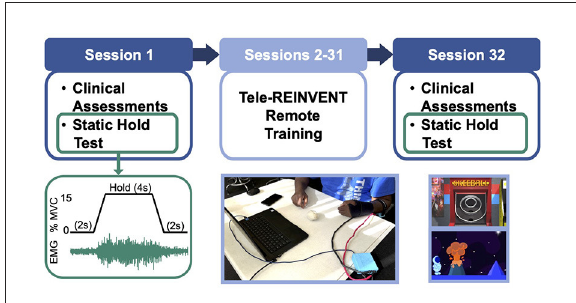
FIGURE1 Experimental protocol. (Top) Timeline of the 32-sessions program. Participants were asked to complete 30 remote sessions (sessions 2–31) targeting training wrist extension activation of the more affected arm. We included pre-, and post-intervention in-person assessments in sessions 1 and 32, respectively. These comprised a battery of standard clinical assessments and a test of neuromuscular control (i.e., repeated static holds with simultaneous electromyography (EMG) and electroencephalography (EEG) recordings). (Bottom, left) Muscle control test (static hold). We tested control over wrist extensor and flexor muscles with a task where participants were asked to maintain a constant level of 15% of a maximal voluntary contraction (MVC) for twelve 4-second epochs while receiving feedback of their muscle EMG amplitude on a computer screen. This test was used to quantify task performance and coherence between brain and muscle signals. (Bottom, middle) Tele-REINVENT system (in a typical session), consisting of